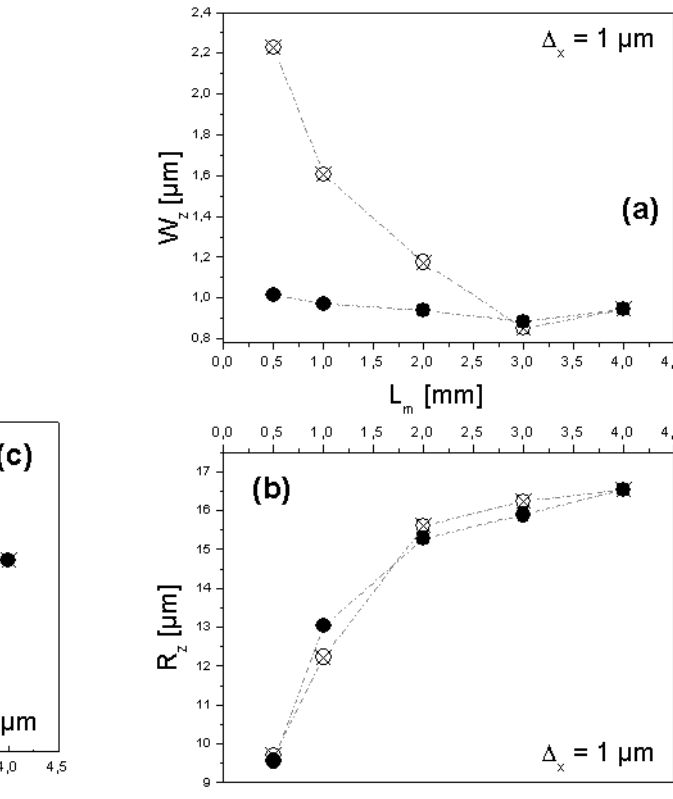
Figure 4. Topographic parameters of a SMC surface as a function of L